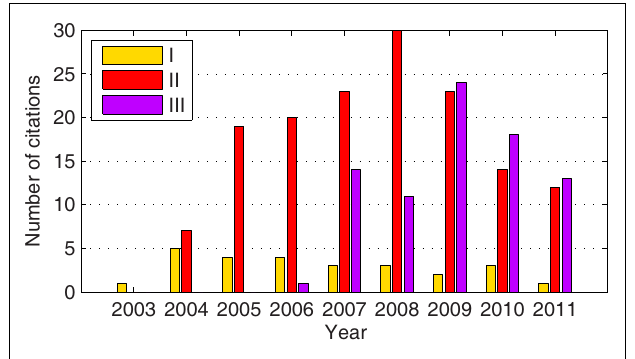
FIGURE 1 | Citations of the overview articles on previous competitions. The histogram shows how many times the editorial articles on BCI competitions I (Sajda et al., 2003), II (Blankertz et al., 2004), and III (Blankertz et al., 2006) have been cited in ISI-indexed journals. Data were retrieved from the ISIWeb of Knowledge on December 1st 2011.